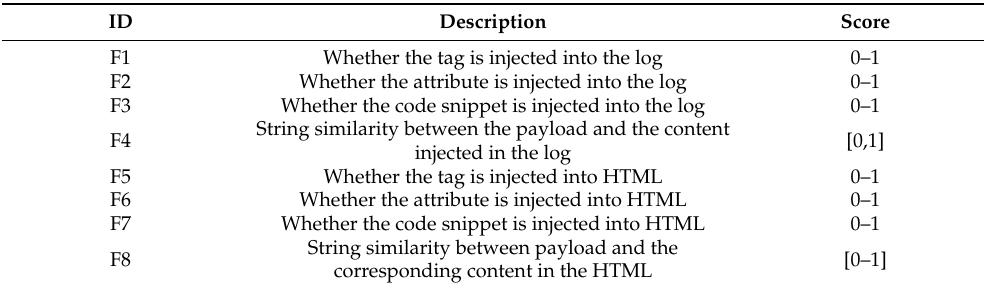
Table 3. Feedback